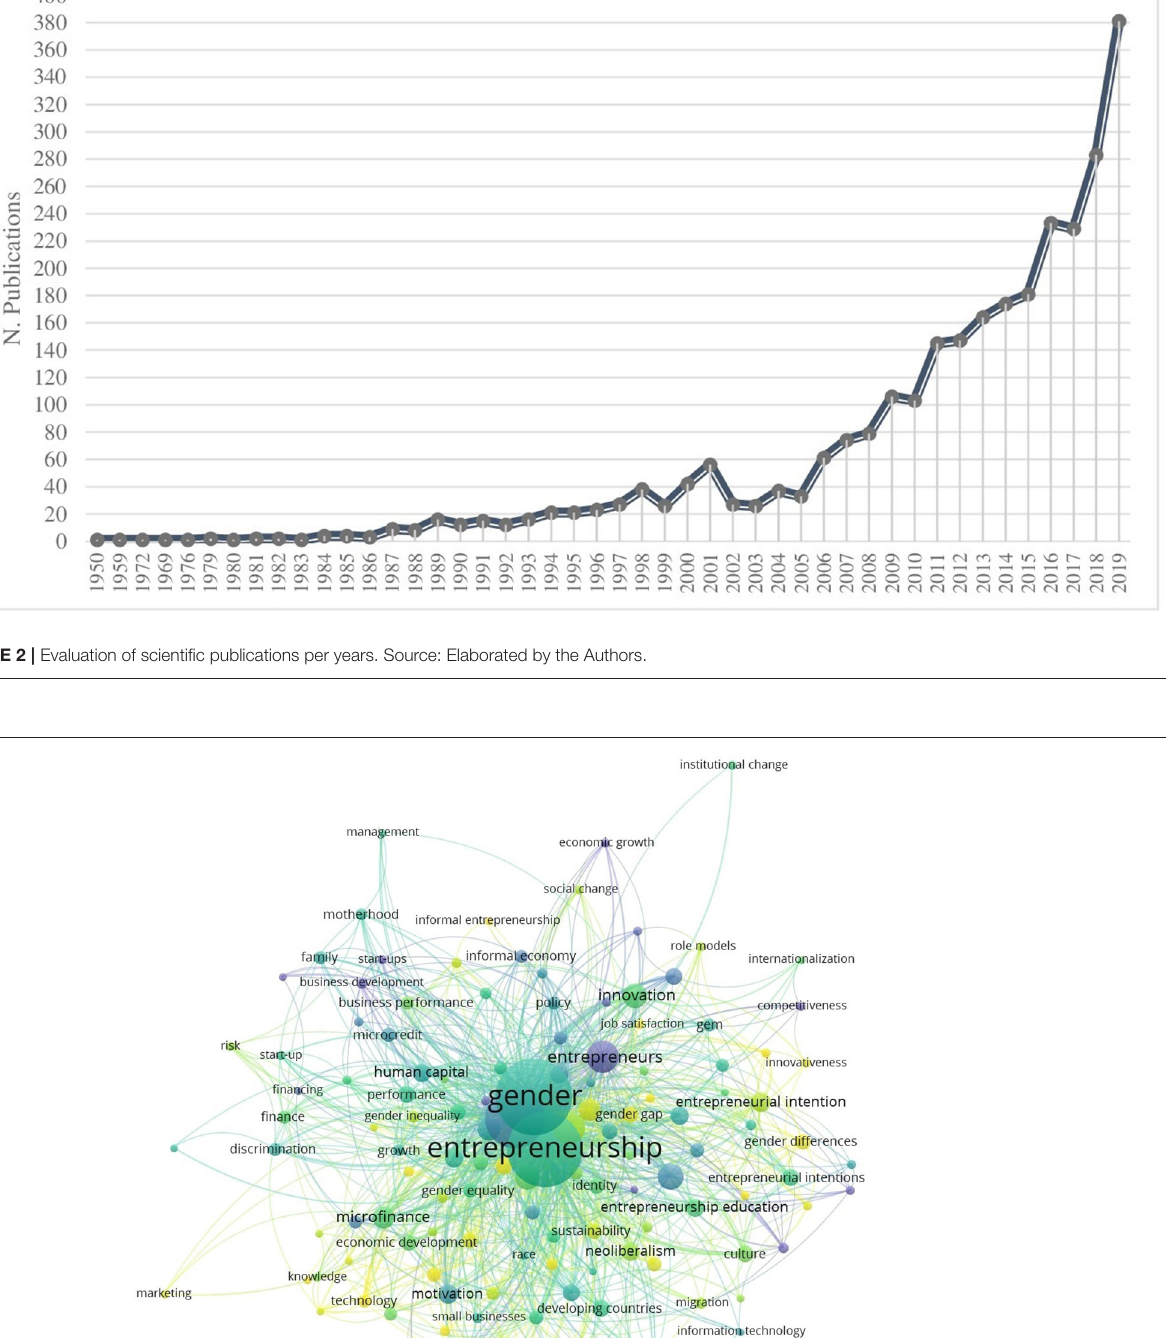
Frontiers in Psychology |